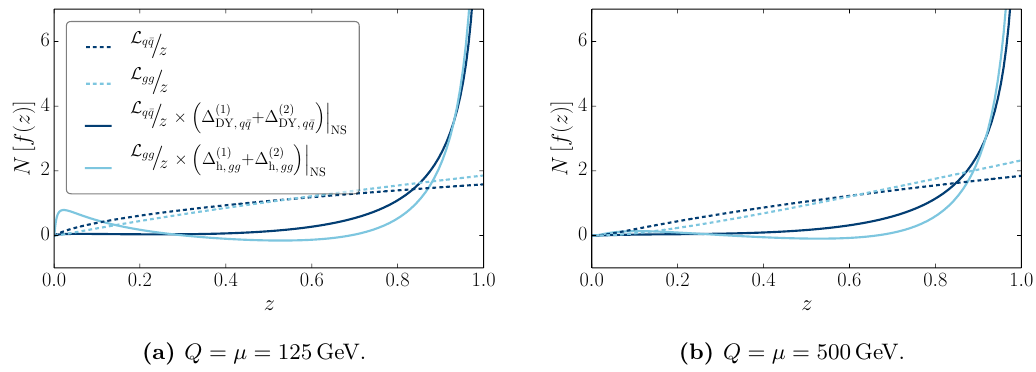
Figure 4. The luminosity function (dashed) and its point-by-point multiplication with the non- singular part of the coefficient functions up to NNLO (solid), for the dominant channel in both DY ( q ¯ q , dark blue) and single Higgs ( gg , light blue) production. All curves are normalized according to eq.